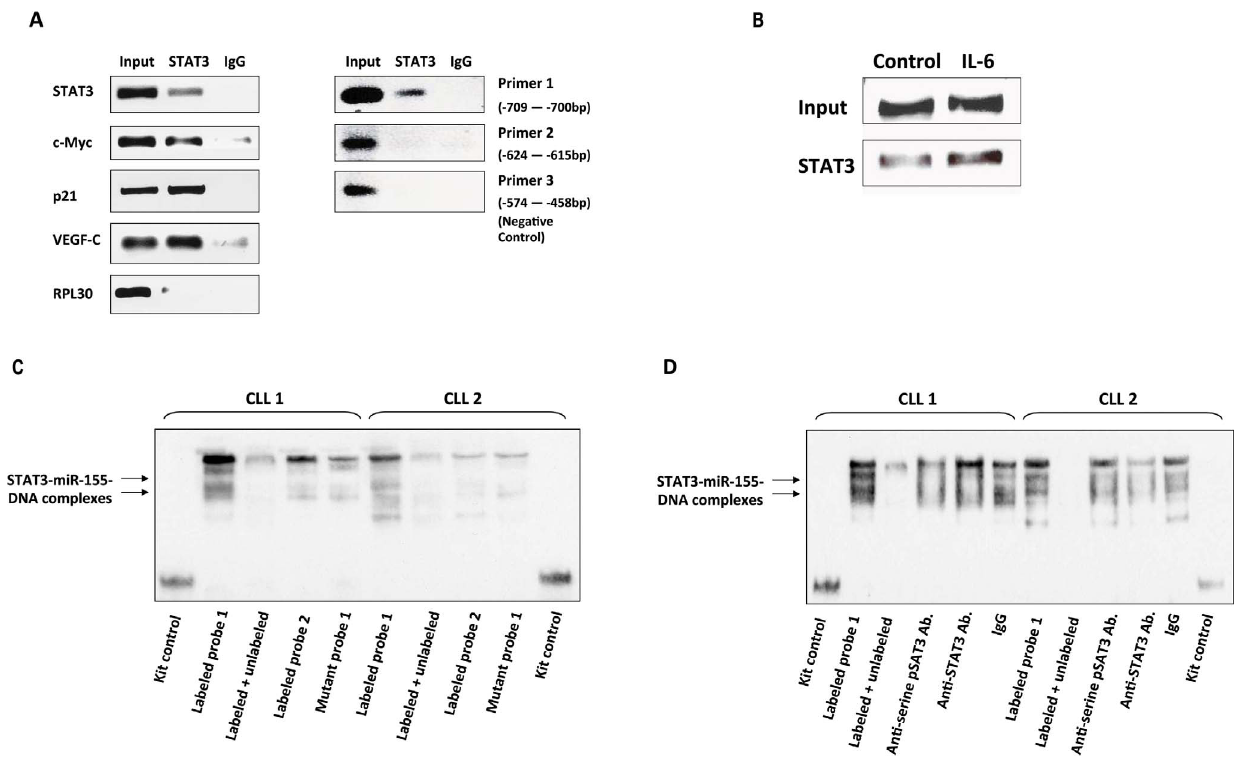
Figure 3. STAT3 binds to the miR-155 promoter. A, Left panel: ChIP of CLL cell nuclear protein revealed that STAT3 co-immunoprecipitated with the DNA of the STAT3 target genes STAT3, c-Myc, p21/WAF1, and VEGF-C, but not that of the control gene RPL30. Right panel: Anti-STAT3 antibodies co-immunoprecipitated with the DNA of probe 1 but not that of probes 2 or 3, suggesting that STAT3 binds to the putative STAT3 binding site 1. In both experiments, immunoglobulin G1 (IgG) was used as an isotypic control. B, ChIP of CLL cells incubated without or with 30 ng/ ml rhIL-6. Using primer 1, we found that the amount of STAT3 DNA that was co-immunoprecipitated with anti-STAT3 antibodies from CLL cells incubated with IL-6 was higher than that from control cells, suggesting that IL-6 enhances the binding of STAT3 to the miR-155 promoter. C. EMSA performed using the cells of two CLL patients demonstrated that CLL cell nuclear protein binds to miR-155– biotinylated (labeled) DNA probe 1 and that excess cold, unlabeled probe attenuates this binding. No significant binding was obtained with labeled probe 2. D, EMSA performed using the cells of the same two CLL patients demonstrated that CLL cell nuclear protein binds to miR-155–labeled DNA probe 1 and that excess cold, unlabeled probe attenuates this binding. The addition of anti-phosphoserine–STAT3 and anti-STAT3 antibodies revealed a similar effect, suggesting that STAT3 binds the miR-155 promoter at binding site 1.